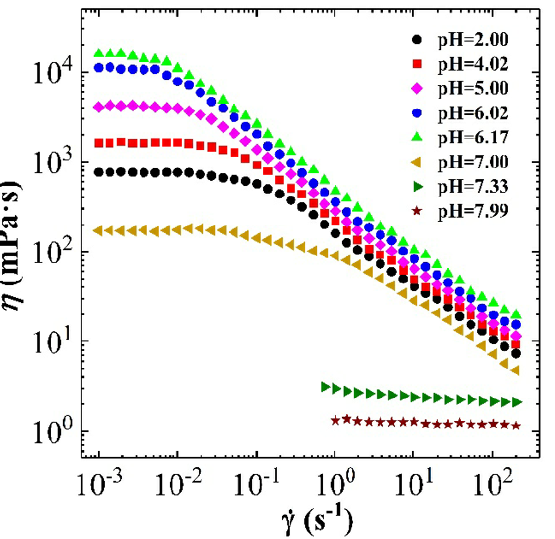
Figure 12. The steady rheological curves for the CTAB-MA based (30 mM CTAB + 15 mM MA) VES-fluid at pH range (2 ≤ pH < 8) and at 25 ◦